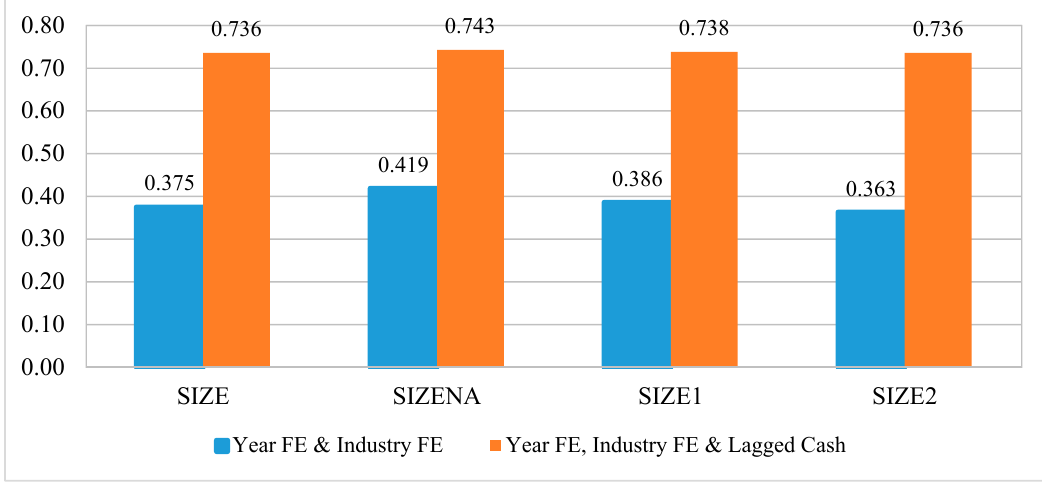
Figure A3. Adjusted R Squared values for alternative firm size measures. Note: This figure shows the goodness of fit when we employ different measures of firm size in the cash holdings regressions (adopted from Table 6 and Table 12 for the main research variable SIZE, and alternative measures, respectively).